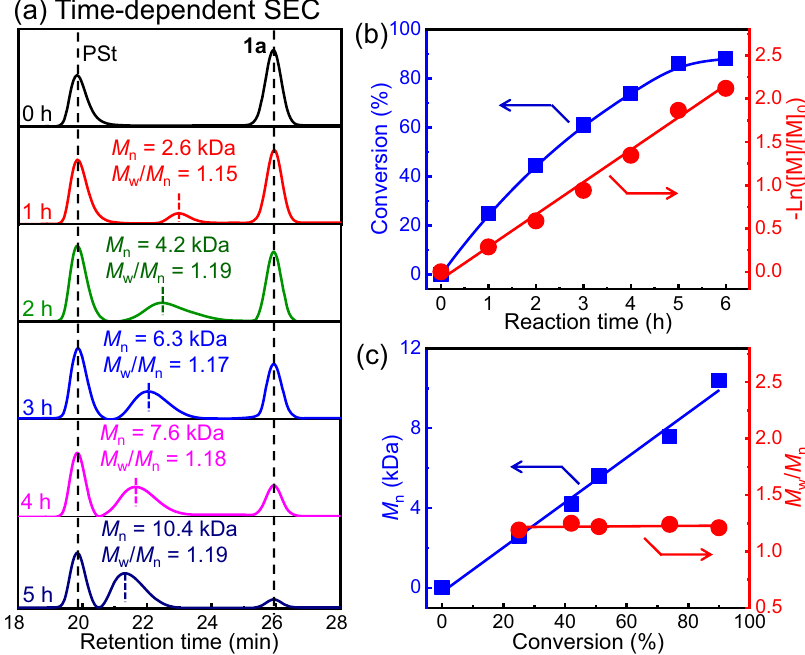
Fig. 3 Time-dependent SEC analyses. a SEC for BT – Ni(dppp)Cl-catalyzed 1a polymerization using polystyrene (PSt) as the internal standard (THF, 25 °C, [ 1a ] 0 /[Ni] 0 = 100). b Plots of 1a conversion and – Ln([M]/[M] 0 ) values vs. polymerization time. c Plots of the M n and M w / M n of the fabricated polymers against 1a conversion.